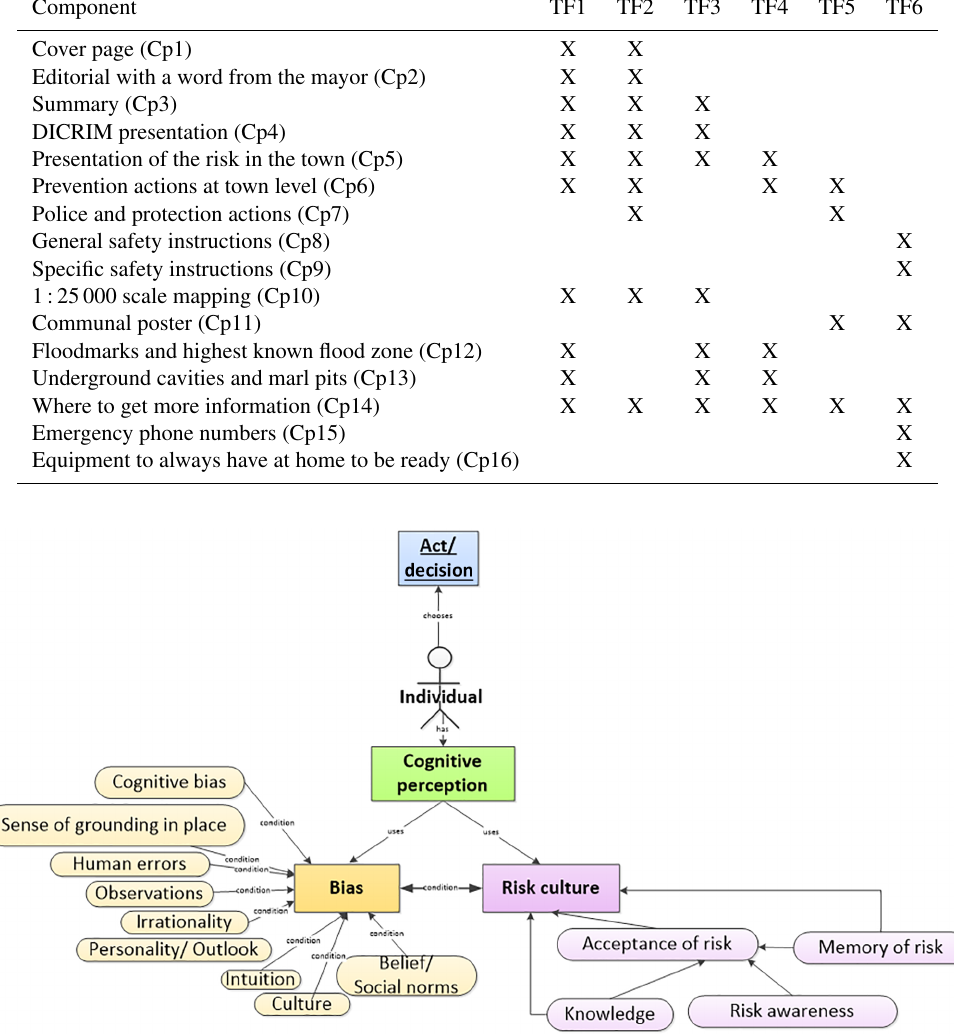
Figure 5. Factors influencing a decision-making process related to the occurrence of a phenomenon.